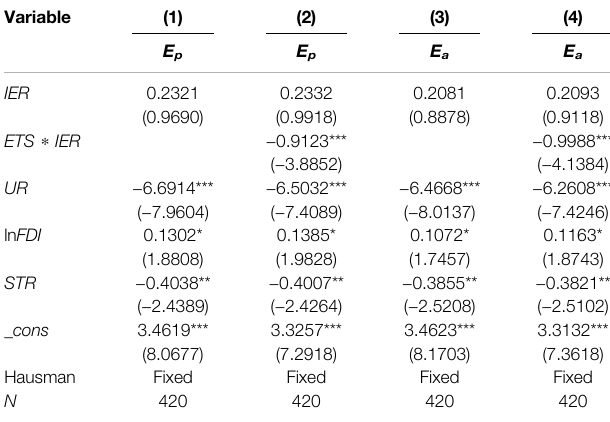
TABLE 4 | Interaction between carbon trading and command-and-control environmental regulations on carbon